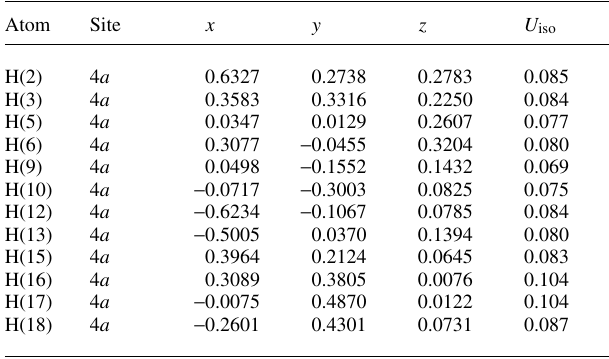
Table 2. Atomic coordinates and displacement parameters (in Å 2 )